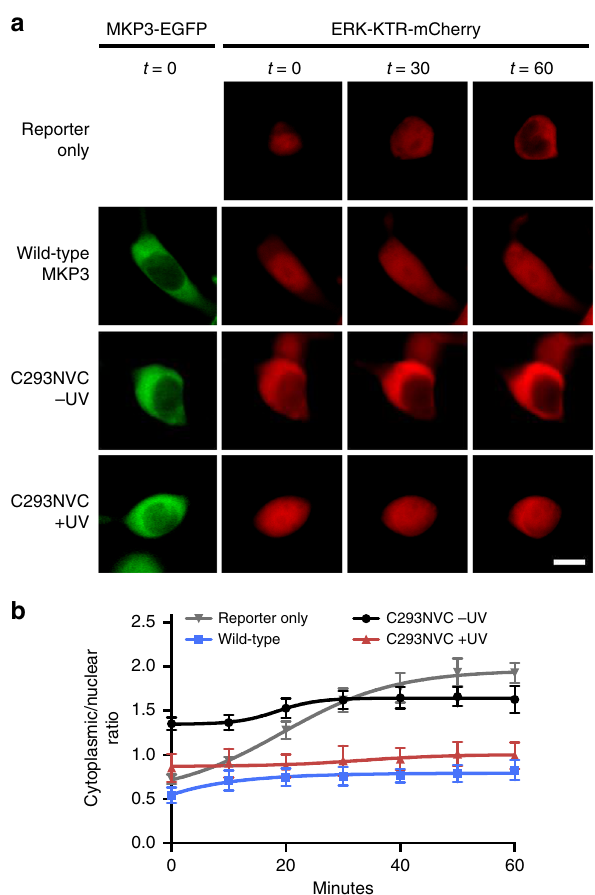
Fig. 3 ERK activity in response to optical activation of the MKP3 catalytic site. a An ERK-KTR-mCherry reporter was utilized to report on the activity of endogenous ERK2 levels in the presence of wild-type, caged, and photoactivated MKP3 variants in HEK293T cells. Wild-type MKP3 prevents EGF-induced triggering of the reporter, while the caged MKP3 is only active following UV exposure (365 nm, 2 min). Scale bar 10 μ m; also see Supplementary Fig. 7. b Quanti fi cation of the cytoplasmic/nuclear ratio for the MKP3 variants shows successful photoactivation of MKP3. Error bars represent standard error of the mean for nine individual cells combined from three biological replicates. One-way ANOVA tests at the 60-minute time point resulted in p < 0.0005 when comparing C293NVC – UV to C293NVC + UV, and reporter only to WT. No signi fi cant difference ( p > 0.1) was observed between WT and C293NVC + UV or reporter only and C293NVC – UV. Data are provided in the Source Data fi